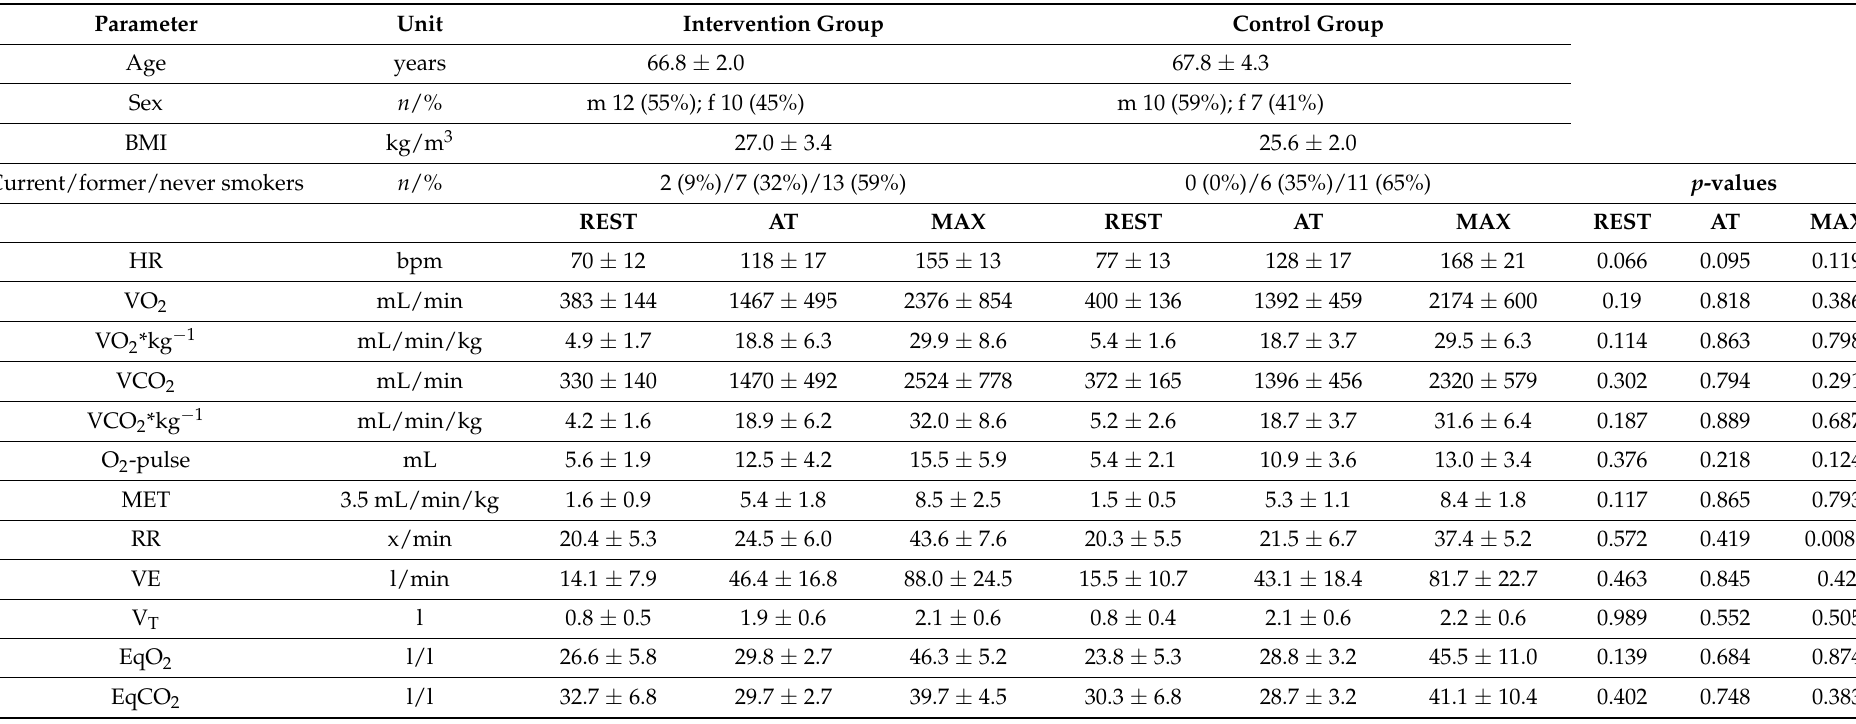
BMI, body mass index; HR, heart rate; VO 2 , oxygen capacity; VO 2 *kg − 1 , oxygen capacity per kilogram; VCO 2 , carbon dioxide production; VCO 2 *kg − 1 , carbon dioxide production per kilogram; O 2 pulse, oxygen pulse; MET, metabolic equivalent of task; RR, respiratory rate; VE, minute ventilation; V T , tidal volume; EqO 2 , breathing equivalent for oxygen; EqCO 2 , breathing equivalent for carbon dioxide; bpm, beats per minute; * statistically